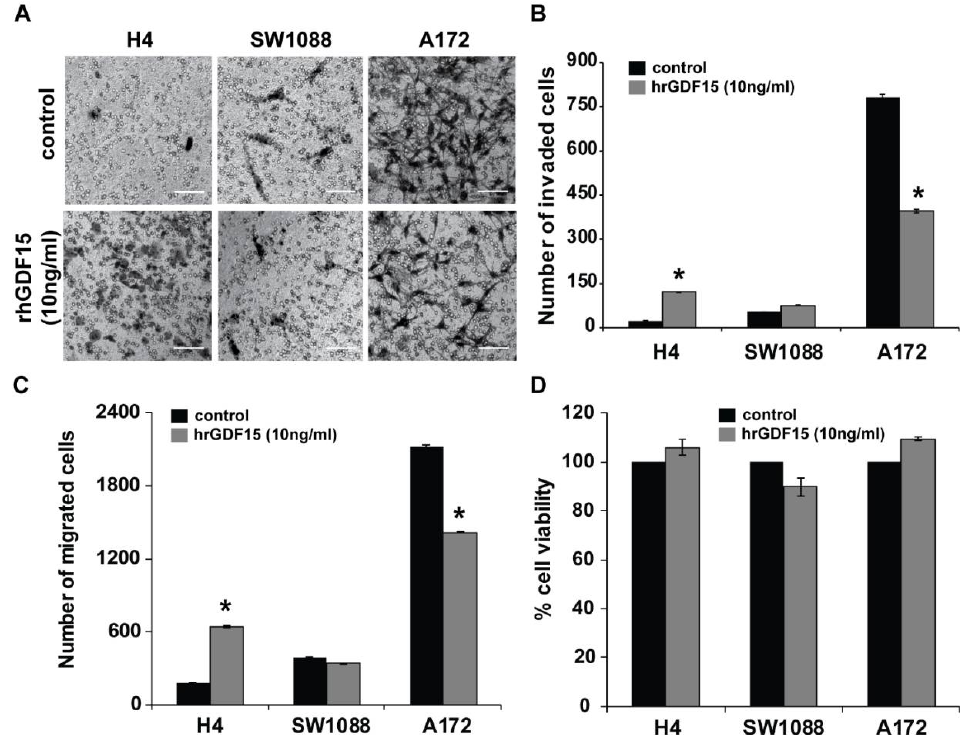
Figure 2. hrGDF15 treatment promotes migration and invasion of less invasive cells and inhibits that of the highly invasive cells without affecting cell survival. ( A ) Control and hrGDF15 (10 ng/mL) treated cells (H4, SW1088 and A172) were subjected to transwell invasion assay 24 h post-treatment. Scale bar: 100 μm. ( B ) Diagrammatic representation of results from invasion assays which depicts the total number of invading glioma cells per transwell for each group (nine randomly chosen microscopic fields per transwell). ( C ) Diagram showing the total number of migrated cells per transwell. Supplementary Figure S1 shows representative images of migration through the transwell for H4, SW1088 and A172 cells. For the invasion and migration assays three independent experiments were performed and each sample was run in duplicate. ( D ) Graph representing the percentage of cell viability as measured by Alamar blue assay 24 h post hrGDF15 treatment for the three cell lines. Each sample was run in triplicate and three independent experiments were performed. Asterisks denote a statistically significant difference ( p < 0.05).